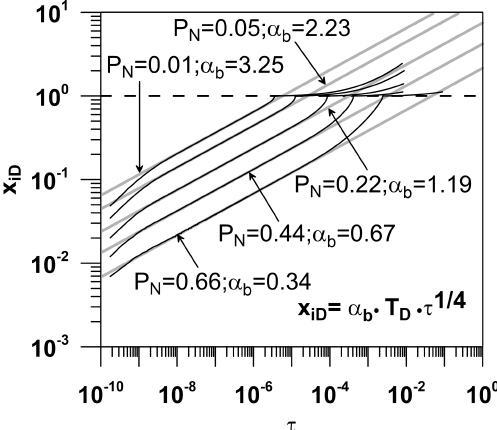
Figure 6. Modeling results in terms of x iD vs. τ on a log–log scale. Propagation of isobars P N = 0 . 01, 0 . 05, 0 . 22, 0 . 44, and 0 . 66 with T D = 6 . 3. The dashed line represents the arrival at the fracture tip of the specific isobars indicated in the